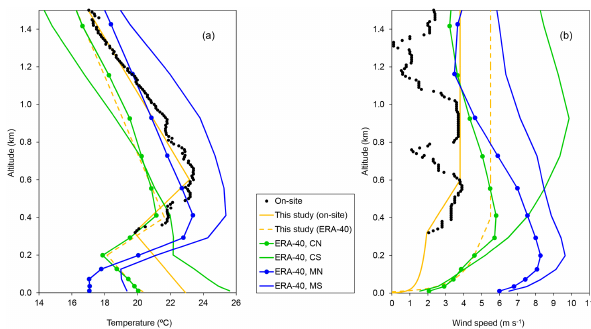
Figure 2. Vertical profiles of temperature and wind speed in the Quinault fire, measured on-site onboard the Convair aeroplane (black dots), at the four ERA-40 grid points closest to the fire (solid green lines for inland points and solid blue lines for marine points) and the two modelled profiles (solid and dashed orange lines). For the modelled profiles based on the ERA-40 analysed data (dashed orange line), we have applied the data at the northern inland point. Notation for the four grid points: CN – continental (i.e.